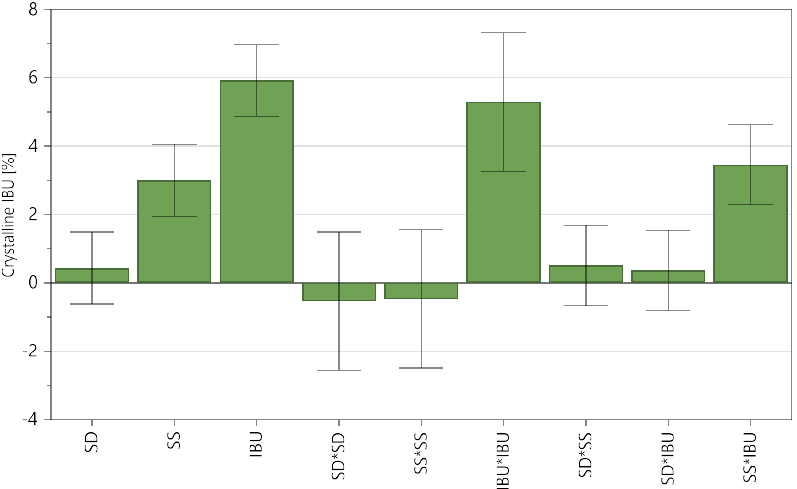
Figure 2. The obtained coefficient values of each input factor. IBU: IBU content in the sample; SD: Feeding rate; SS: Screw speed.